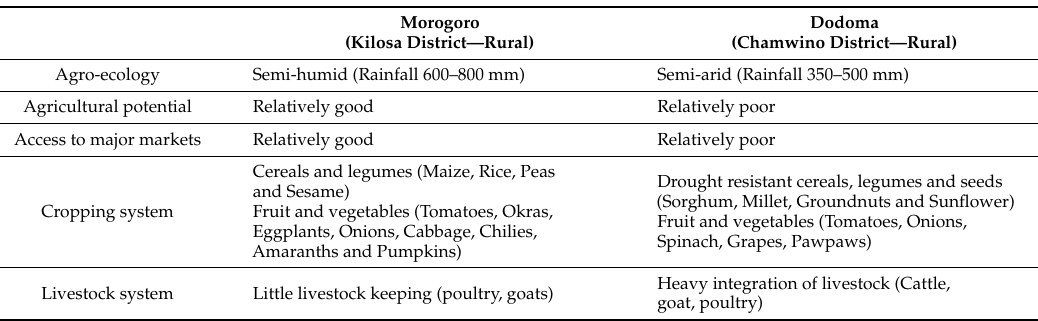
Table 1. Summary of main characteristics of study area.